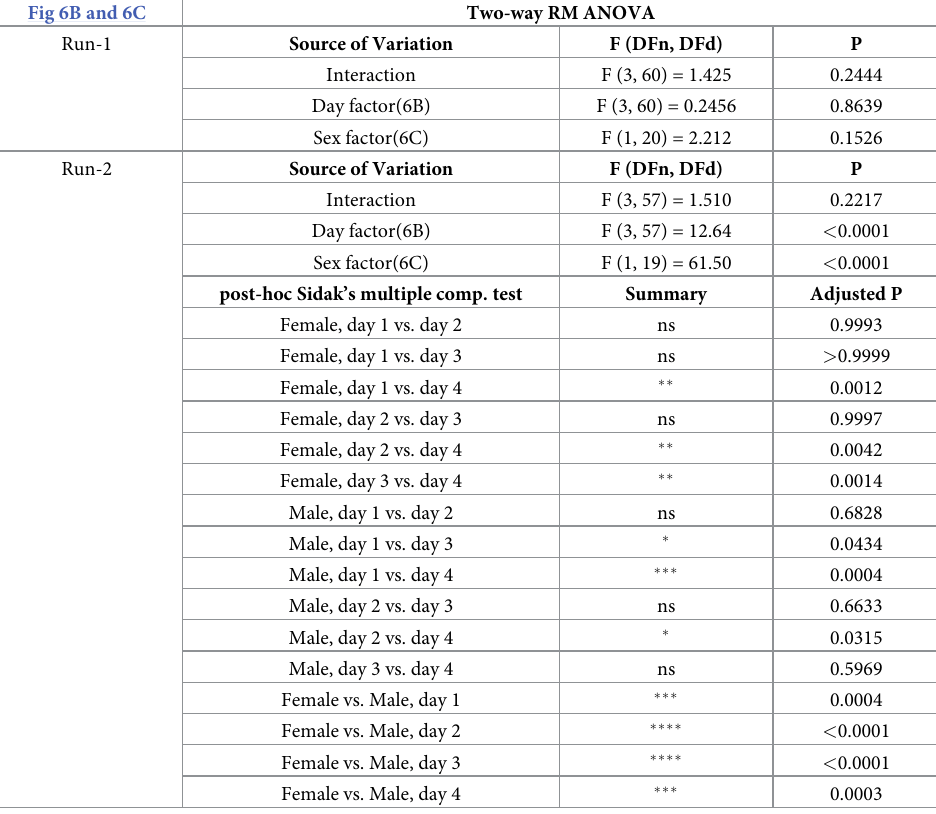
Table 8. Statistical analysis of data shown in Fig 6B and 6C for place learning with corner switch, cohort B, Run- 1, and Run-2. Fig 6B and 6C